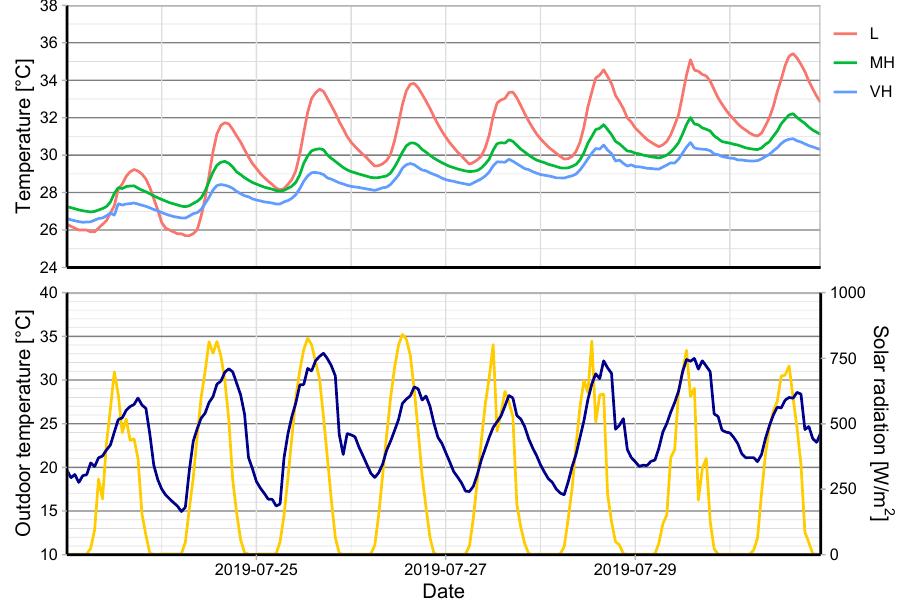
Figure 5. The temperature course in light, medium heavy, and very heavy rooms as a function of outdoor temperature and solar radiation during heat wave 23–30 July